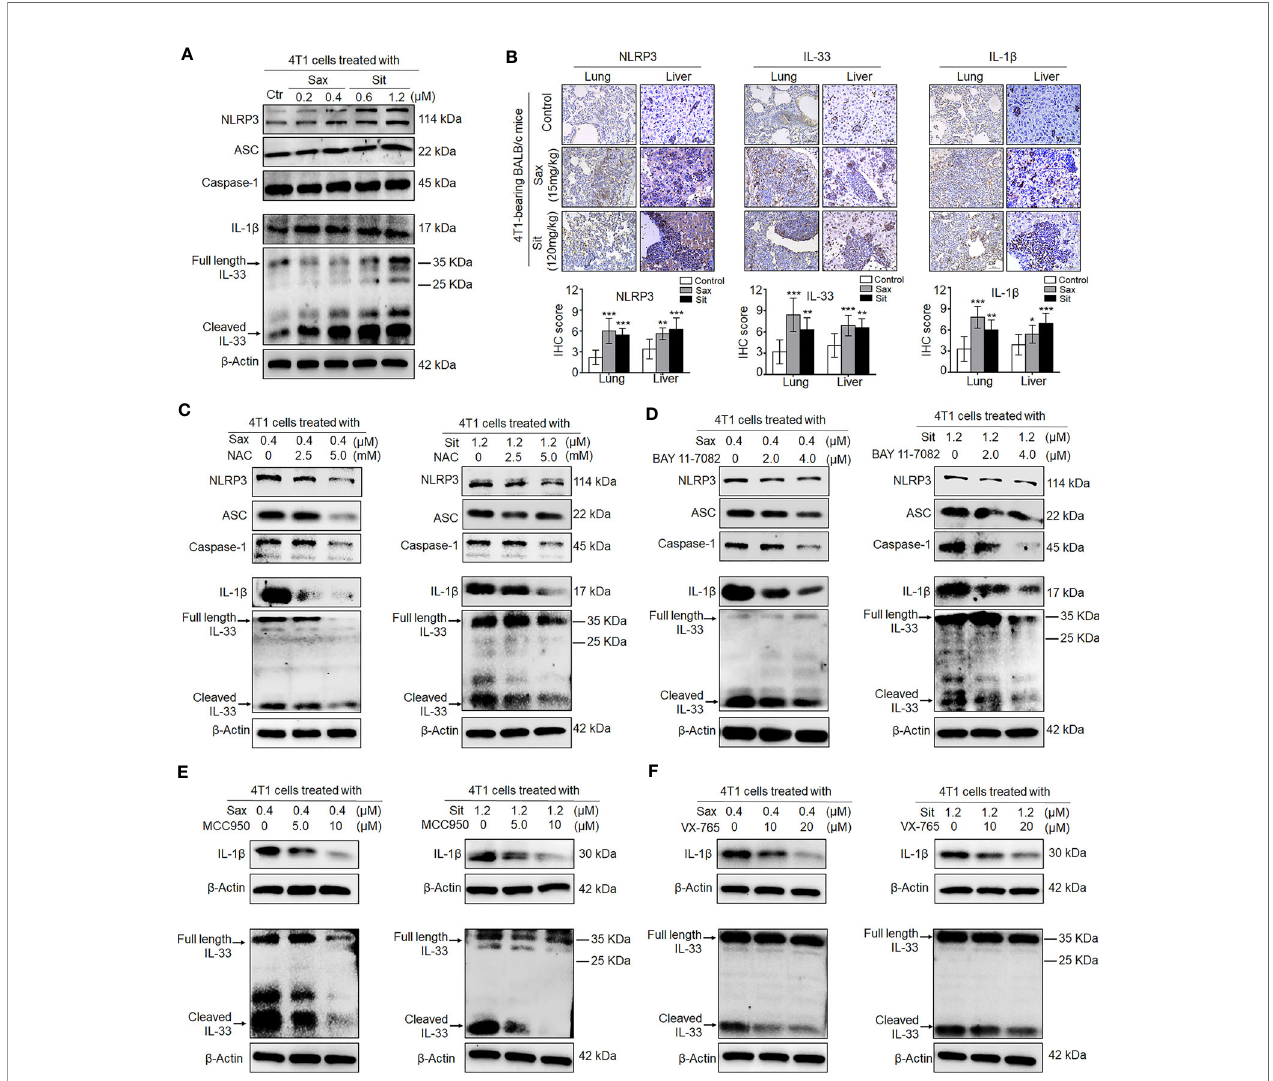
FIGURE 7 | DPP-4i triggers NLRP3 in fl ammasome activation via ROS – NF- к B axis. (A) DPP-4i triggers NLRP3 in fl ammasome activation in 4T1 cells. 4T1 cells were treated with Sax (0.4 m M) or Sit (1.2 m M) for 24 h, and NLRP3 in fl ammasome-associated proteins were detected by Western blotting. (B) DPP-4i enhances NLRP3 in fl ammasome of BC cells in vivo . 4T1-bearing BALB/c mice were treated with Sax (15 mg/kg) or Sit (120 mg/kg) via oral gavage daily. NLRP3, IL-1 b , and IL-33 were detected by IHC staining in lung and liver metastatic tissues. (C) ROS inhibition attenuates DPP-4i-induced NLRP3 in fl ammasome activation. 4T1 cells were co- treated with Sax (0.4 m M) or Sit (1.2 m M) and NAC (0, 2.5, and 5 mM), respectively, and NLRP3 in fl ammasome- associated proteins were detected by Western blotting. (D) NF- к B blockage decreases DPP-4i-triggered NLRP3 in fl ammasome activation. 4T1 cells were co-treated with Sax (0.4 m M) or Sit (1.2 m M) and BAY 11- 7082 (0, 2, and 4 µM) respectively, and NLRP3 in fl ammasome-associated proteins were detected by Western blotting. (E) Inhibition of NLRP3 activation attenuates DPP-4i-triggered IL-1 b and IL-33 expression. 4T1 cells were co-treated with Sax (0.4 m M) or Sit (1.2 m M) and NLRP3 inhibitor MCC950 (0, 5, and 10 m M) respectively, and IL-1 b and IL-33 cytokines were detected by Western blotting. (F) Inhibition of caspase-1 activation attenuates DPP-4i-triggered IL-1 b and IL-33 expression. 4T1 cells were cotreated with Sax (0.4 m M) or Sit (1.2 m M) and caspase-1 inhibitor XV-765 (0, 10, and 20 µM), respectively, and IL-1 b and IL-33 cytokines were detected by Western blotting. b -Actin was a loading control. Data are presented as mean ± SD of three independent experiments. Representative images are shown. Scale bar: 50 m m. *p < 0.05, **p < 0.01, and ***p < 0.001 between the indicated groups determined by unpaired Student ’ s t-test or the one-way analysis of variance